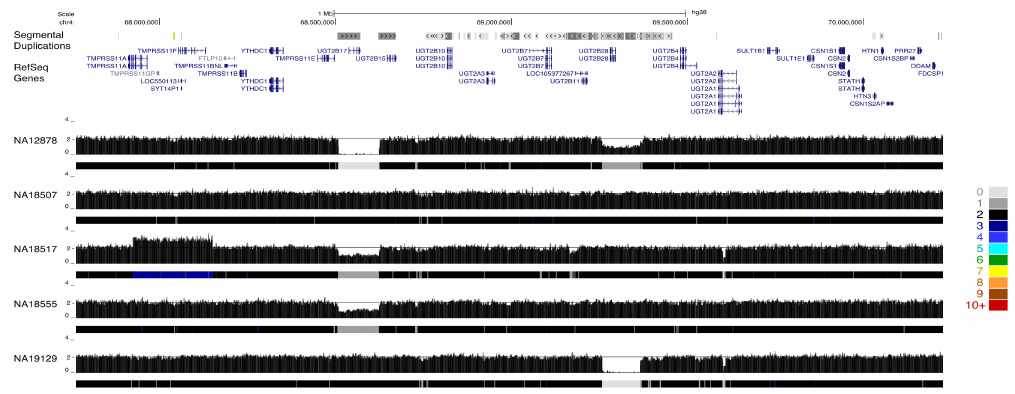
Figure 3. Paralog-specific CNV detection at the UGT2B locus. A genome browser snapshot is shown for an interval on chromosome 4 that includes several related UGT2B genes. Regions of segmental duplication and RefSeq gene models are indicated at the top of the image. This is followed by paralog specific copy-number profiles for five individuals. Each profile includes the raw estimated copy number in 1000 k-mer windows as well as a heatmap track depicting the estimated copy-number. The key for the heatmap track is shown to the right of the figure. Variation e ff ecting distinct UGT2B paralogs is apparent. For example, sample NA12878 is estimated to contain zero copies of the UGT2B17 gene and one copy of UGTB28, NA19129 contains two copies of UGTB17, and UGT2B28 is totally absent. The authors of [9] have previously validated the variation at this